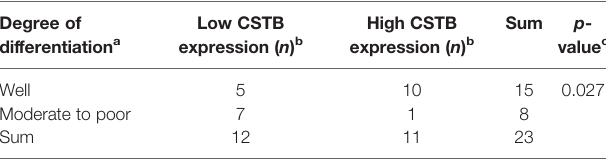
TABLE 1 | Association between CSTB expression and tissue differentiation. Degree of differentiation